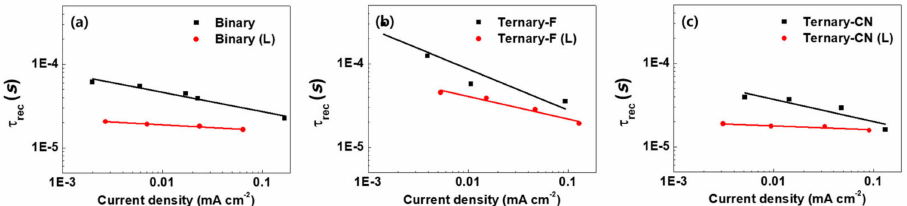
Figure 8. Plots of recombination lifetime vs. current density for ( a ) Binary, ( b ) Ternary-F, and ( c ) Ternary-CN before and after the light soaking.